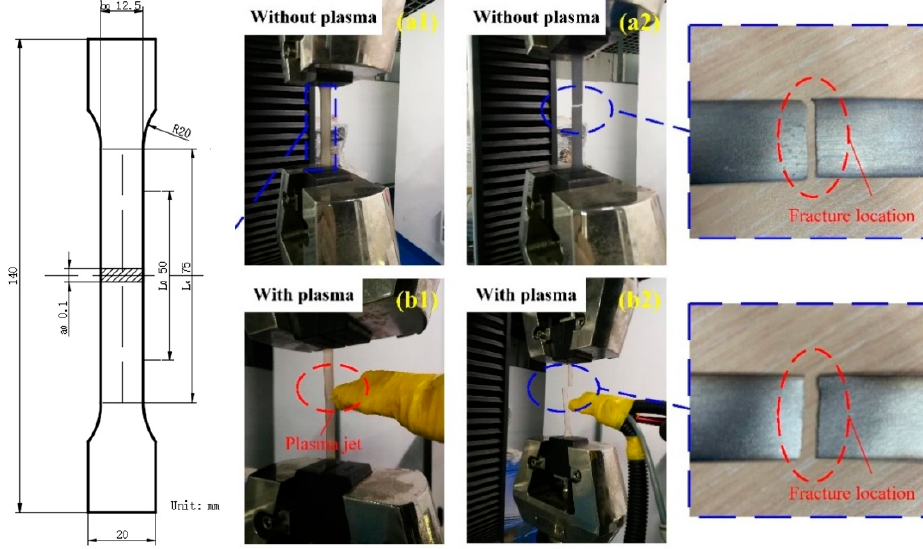
Figure 4. Sketch map of tensile specimens and tensile test.